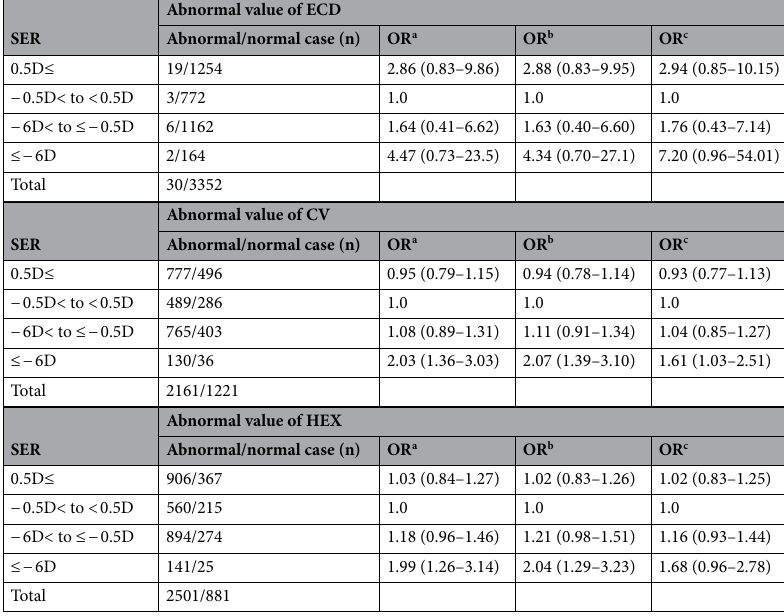
Table 4. Adjusted odds ratio of having the abnormal value of endothelial cell density, coefficient of variation, and hexagonality according to spherical equivalent refraction in female participants. ECD endothelial cell density, CV coefficient of variation, HEX hexagonality, n number, D diopter, OR odds ratio. a Adjusted for age. b Further adjusted for intraocular pressure, keratometric power, height, and antihypertensive drug use. c Further adjusted for a history of contact lenses